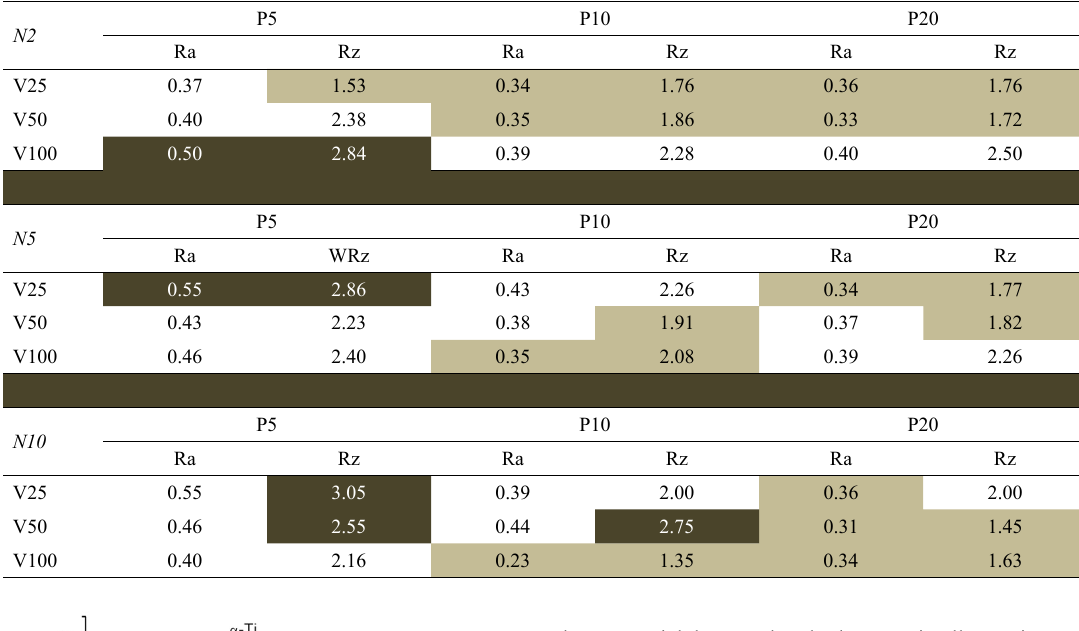
Table 3. Average values of Ra and Rz for each experimental condition after N=2, 5 and 10 (in µm). N2